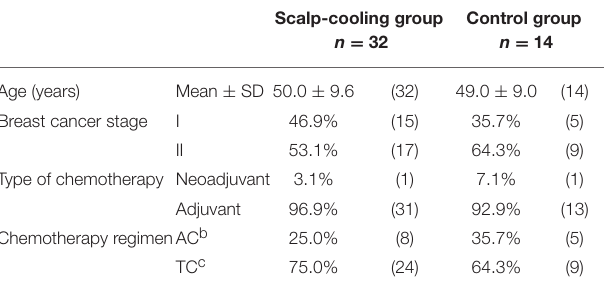
TABLE 1 | Patient demographics (ITT population a ).